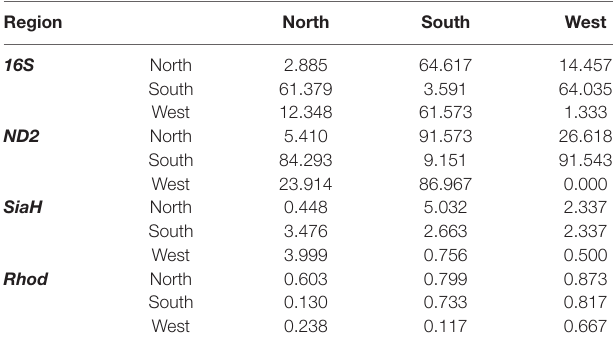
TABLE 3 | Genetic distances between north, south, and west groups of the P. nordestinus